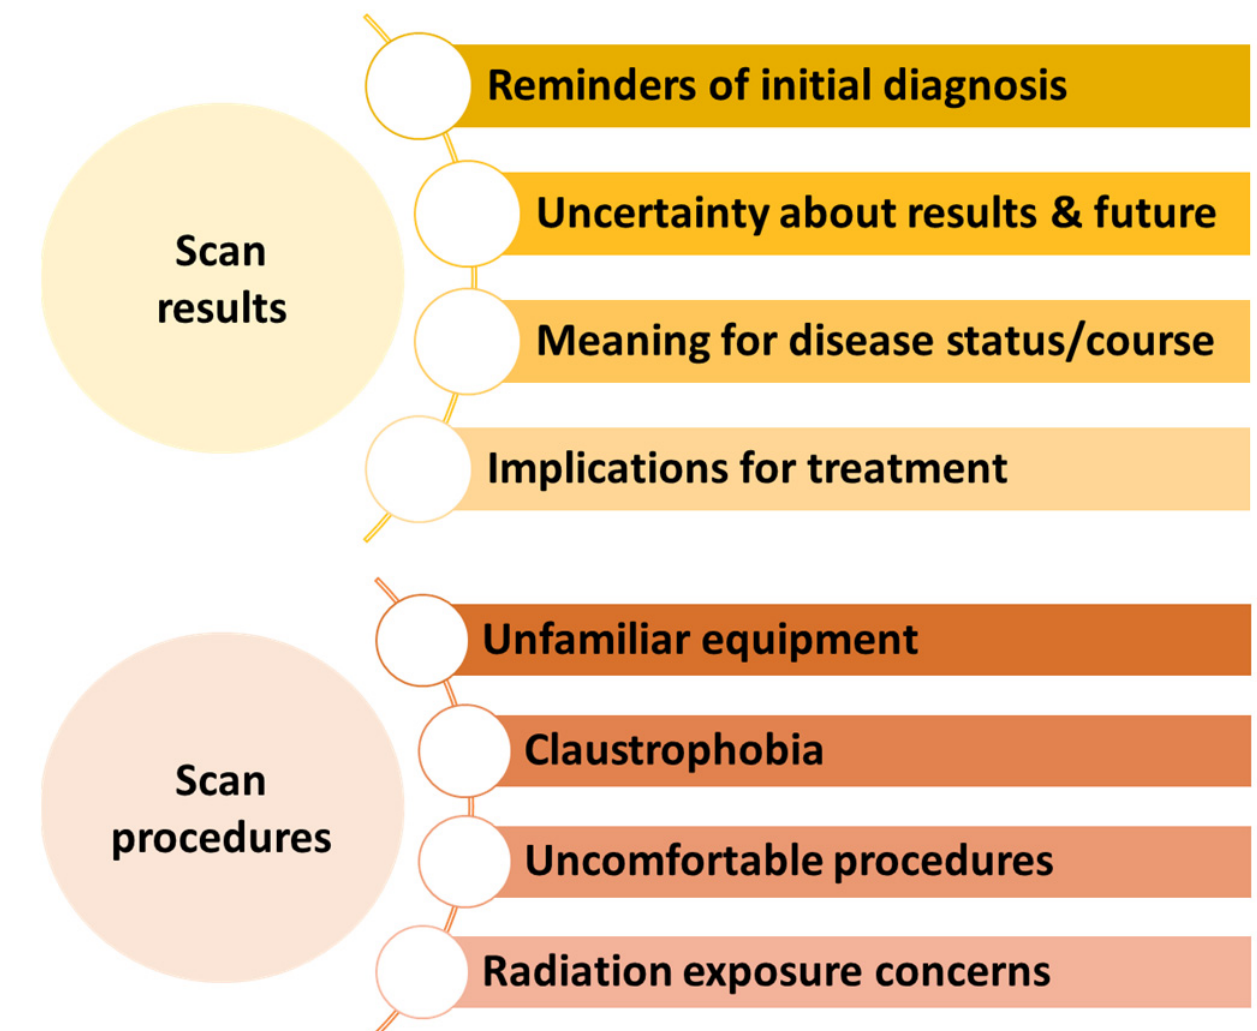
Figure 2. Dimensions of scanxiety, clustering around scan procedures and scan results.